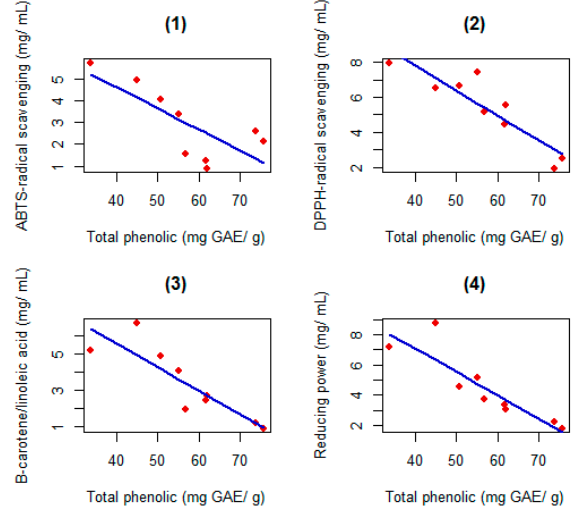
Figure 1. Regression equations estimated for the four evaluation methods of the antioxidant activity in relation to the amounts of total phenols. ( 1 ) y = − 0.0965 x + 8.4587 ( R 2 = 57%, p < 0.01); ( 2 ) y = − 0.1429 x + 13.5332 ( R 2 = 82%, p < 0.01); ( 3 ) y = − 0.1294 x + 10.7458 ( R 2 = 76%, p < 0.01); ( 4 ) y = − 0.1539 x + 13.2256 ( R 2 = 79%, p < 0.01).